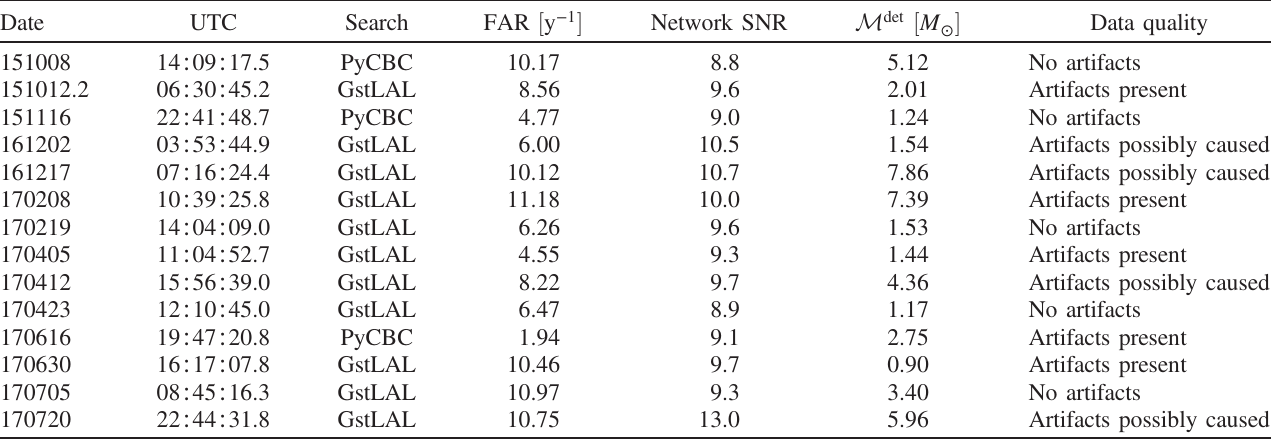
TABLE II. Marginal triggers from the two matched-filter CBC searches. To distinguish events occurring on the same UTC day, we extend the YYMMDD label by decimal fractions of a day as needed, always rounding down (truncating) the decimal. The search that identifies each trigger is given, and the false alarm and network SNR. This network SNR is the quadrature sum of the individual detector SNRs for all detectors involved in the reported trigger; that can be fewer than the number of nominally operational detectors at the time, depending on the ranking algorithm of each pipeline. The detector chirp mass reported is that of the most significant template of the search. The concentration of our marginal triggers at low chirp masses is consistent with expectations for noise triggers, because search template waveforms are much more densely packed at low masses. The final column indicates whether there are any detector characterization concerns with the trigger; for an explanation and more details, see the